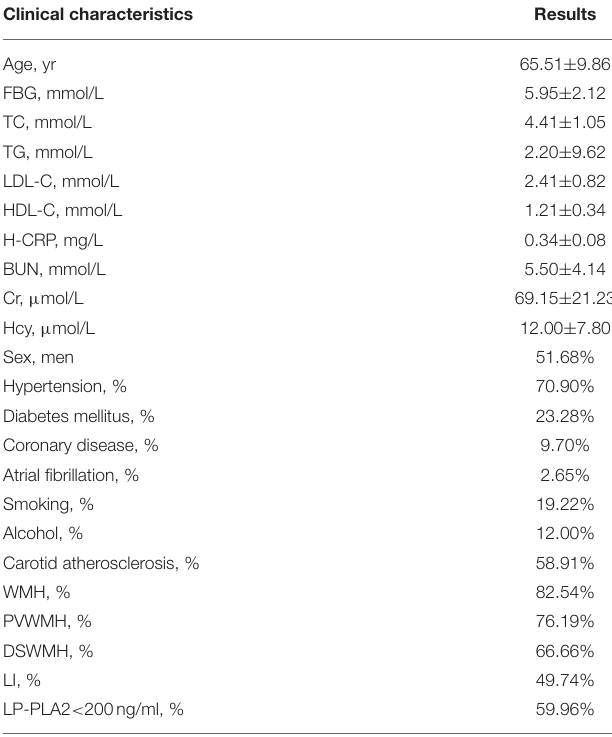
TABLE 1 | Baseline characteristics of the